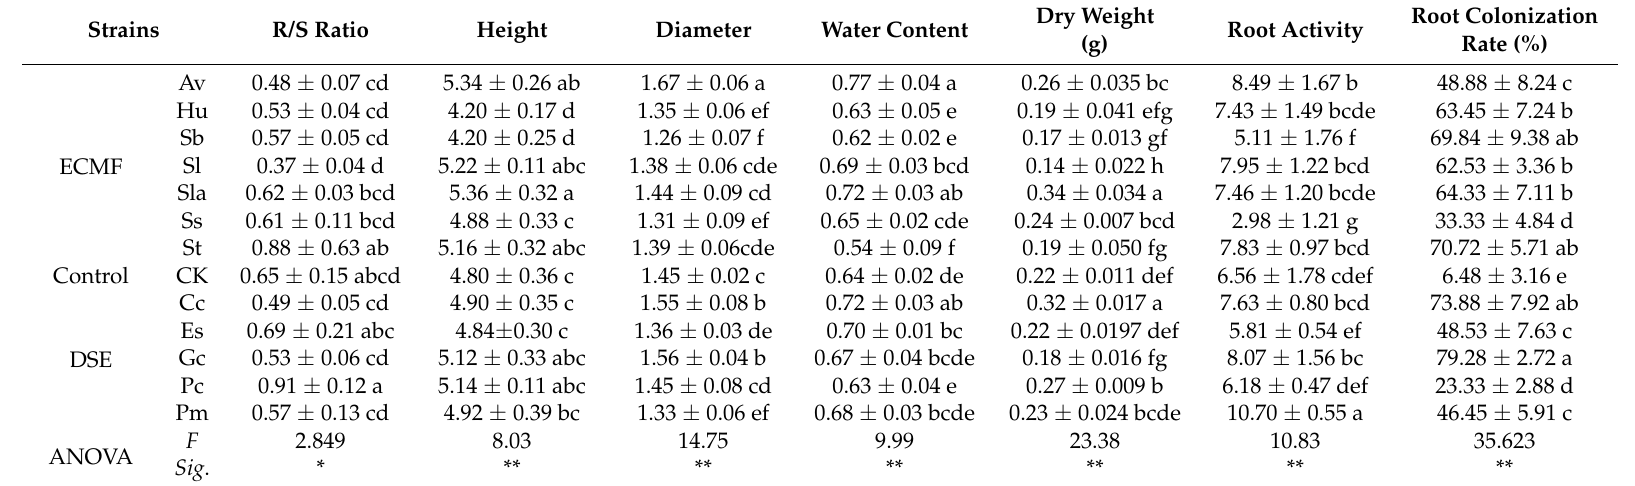
Table 1. ANOVA analysis of seedlings’ growth and the colonization of ECMF and DSE strains 3 months after transplant.